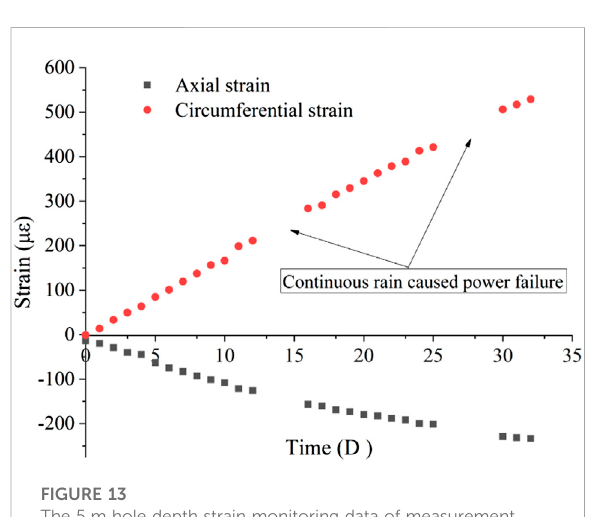
FIGURE 13 The 5 m hole depth strain monitoring data of measurement hole No. 1.